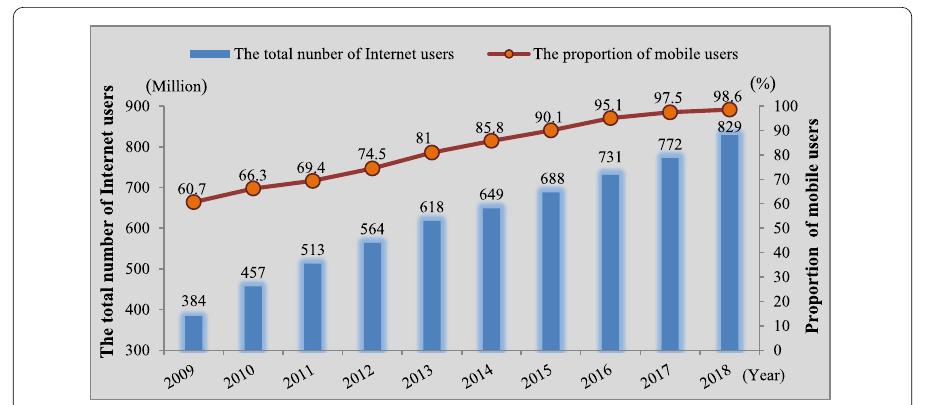
Figure 1 The development trend of Internet users in China